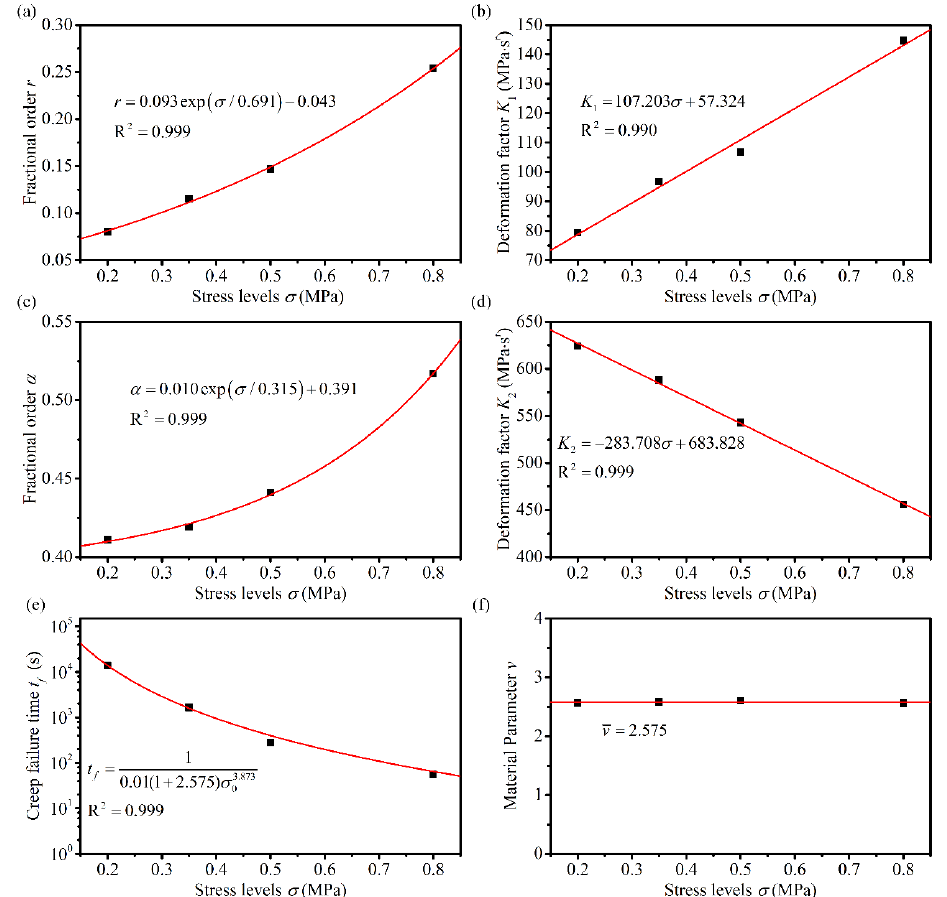
Figure 8. Variation of the proposed model parameters with stress levels at 50 °C ( a ) r , ( b ) K 1 , ( c ) α , ( d ) K 2 , ( e ) t f , and ( f ) v .